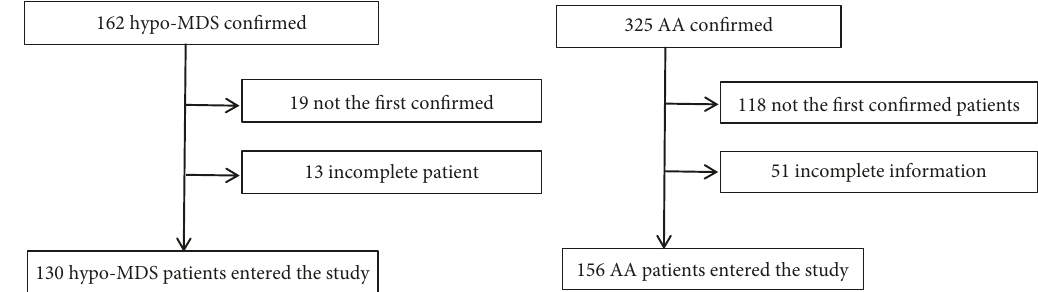
Figure 3: The selection of research